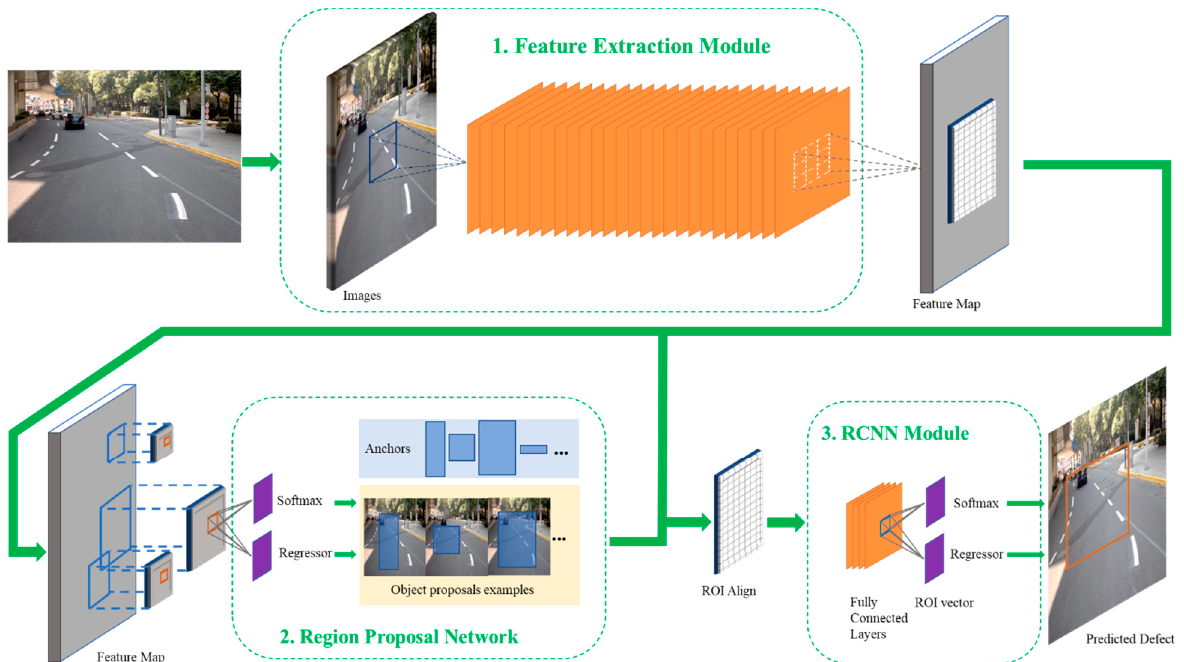
Figure 3. Architecture of Faster RCNN Baseline.